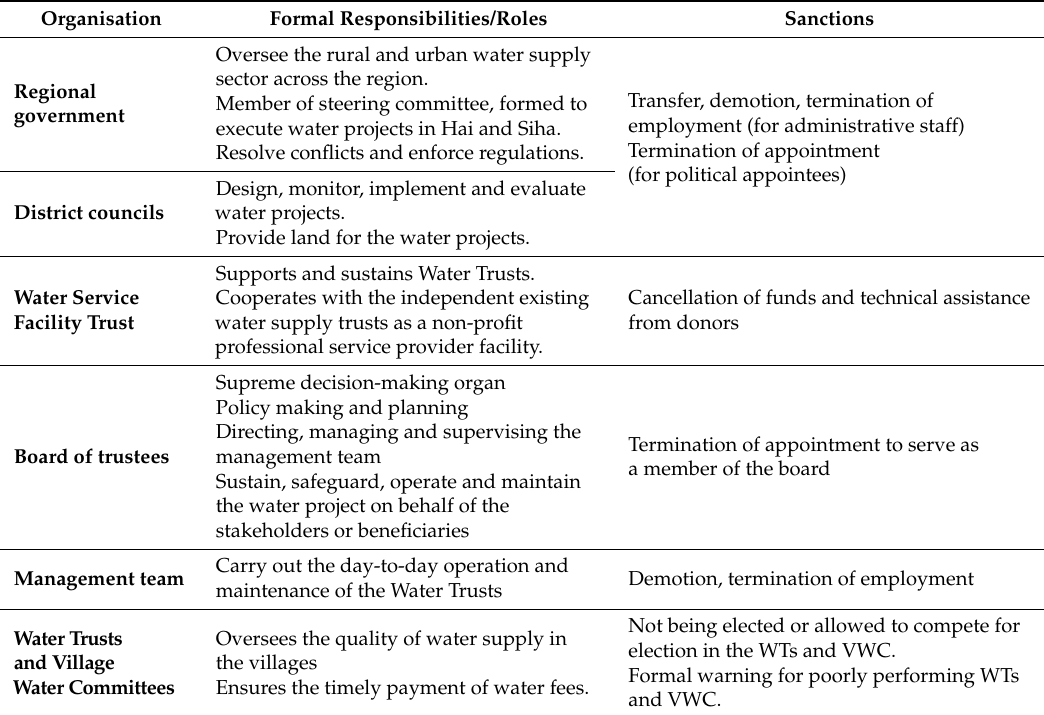
Table 2. A summary of formal responsibilities and sanctions of various organisational levels in Hai and Siha (Source: Fieldwork data,